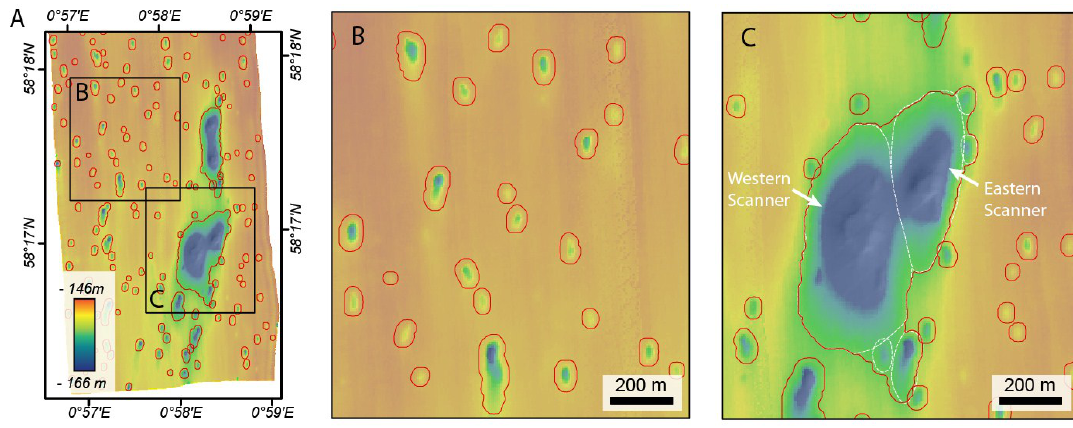
Figure 12. Examples of the initial results from BGS toolbox for SEA 2 Box 4—the pockmarks delineated by the tool are shown in red over a colour-shaded relief map from the southern part of Box 4. Resolution 6 m. Note that manual editing was later required to split the Scanner Pockmark Complex (SPC) into Western Scanner, Eastern Scanner, and adjacent pockmarks.